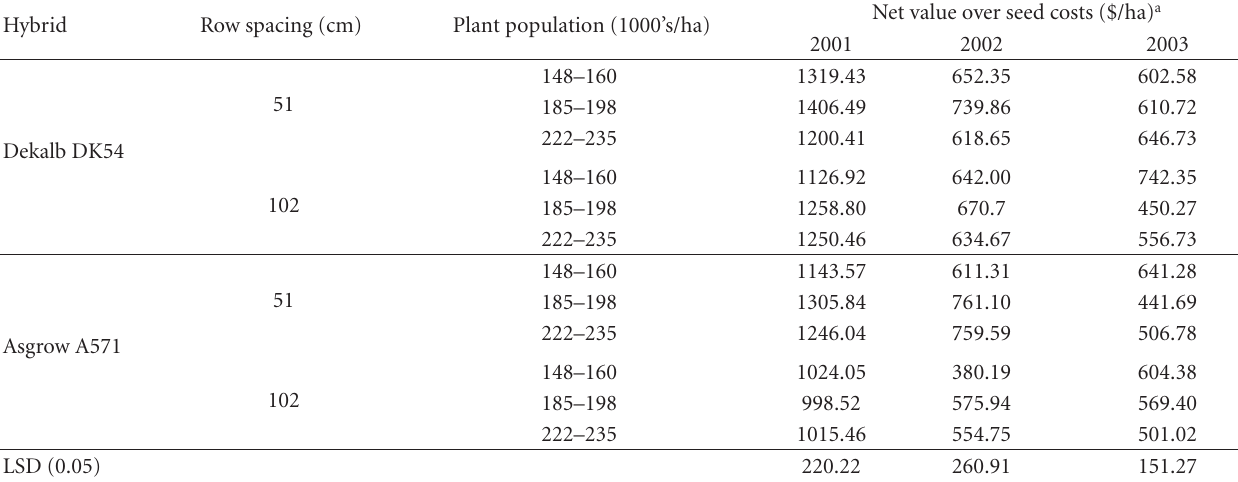
Table 3: Grain sorghum net dollar value per hectare minus seed costs as influenced by hybrid, row spacing, and seeding rate. Hybrid